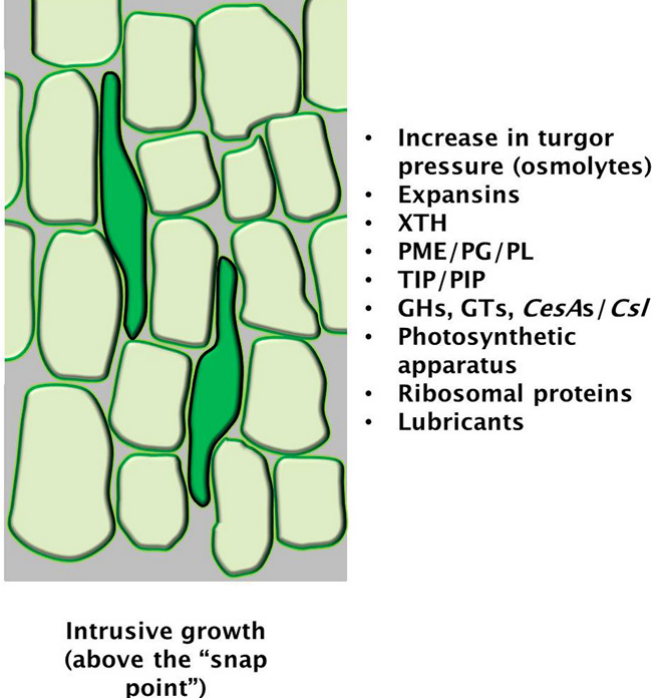
Figure 4. Cartoon representing the diffuse (intrusive) growth of bast fibres (dark green cell grows showing intrusive extremities, as in [20]). The box shows important factors/genes involved [20,47]. Abbreviations: XTH xyloglucan endotransglycosylase/hydrolase, PME pectin methylesterase, PG polygalacturonase, PL pectin lyase, TIP tonoplast intrinsic protein, PIP plasma membrane intrinsic protein, GHs glycosylhydrolases, GTs, glycosytransferases, CesA s cellulose synthases, Csl cellulose